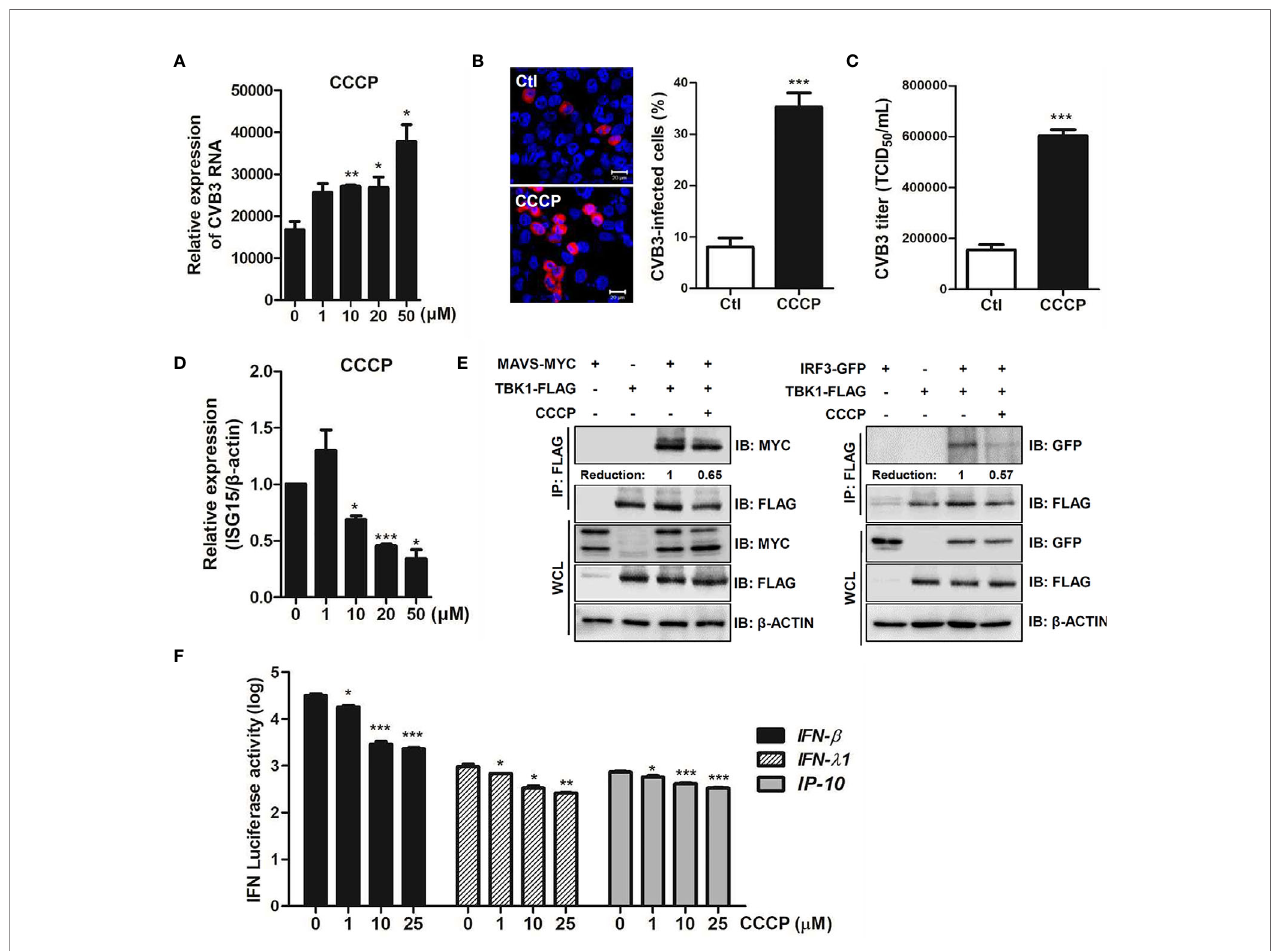
FIGURE 7 | CCCP facilitates CVB3 replication via inhibition of host innate immune signaling. (A) HeLa-Parkin cells were treated with CCCP at various concentrations and infected with CVB3 at an MOI of 1 for 8 h. CVB3 RNA copy number was quantitated, normalized, and analyzed by quantitative realtime PCR (mean ± SD; n = 3). Statistical analysis: *p < 0.05; **p < 0.01, vs . DMSO-treated cells. (B) Cells were immunostained with anti-Coxsackievirus B3 antibody and are indicated in red. The images are representative of three independent experiments. CVB3-infected cells were counted and are presented as percentage (%) in the graph. (C) Supernatants were collected from HeLa-Parkin cells and viral titers were measured by TCID50 assay. (D) HeLa-Parkin cells were treated with CCCP at various concentrations and infected with CVB3 at an MOI of 1 for 8 h. ISG15 mRNA level was measured by quantitative realtime PCR (mean ± SD; n = 3). Statistical analysis: *p < 0.05; ***p < 0.001, vs . DMSO-treated cells. (E) HeLa-Parkin cells were transfected with MYC-tagged MAVS and TBK1-FLAG (left) or IRF3-GFP and TBK1-FLAG-encoding plasmids and treated with or without 10 m M CCCP for 2h. The media was replaced and cells were incubated for 24 h. Next day, cells were lysed and precipitated using anti-FLAG antibody. The cell lysates and immunoprecipitates were analyzed by immunoblot analysis using anti-FLAG and anti-MYC antibodies. Relative densitometric analysis of immunoblot is presented with normalized densitometric units plotted against the treatment (shown as numbers). WCL, whole cell lysates (F) HeLa-Parkin cells were transfected with plasmids encoding RIG-I-FLAG for 24 h and transiently co-transfected with IFN- b , IFN- l 1, and IP-10 luciferase reporter plasmids and a Renilla luciferase reporter plasmid (internal control). After 24 h of transfection, DMSO or CCCP was added to the cells for 2 h. Relative luciferase activity is shown (mean ± SD; n = 3). p < 0.05; **p < 0.01; ***p < 0.001, vs . DMSO-treated